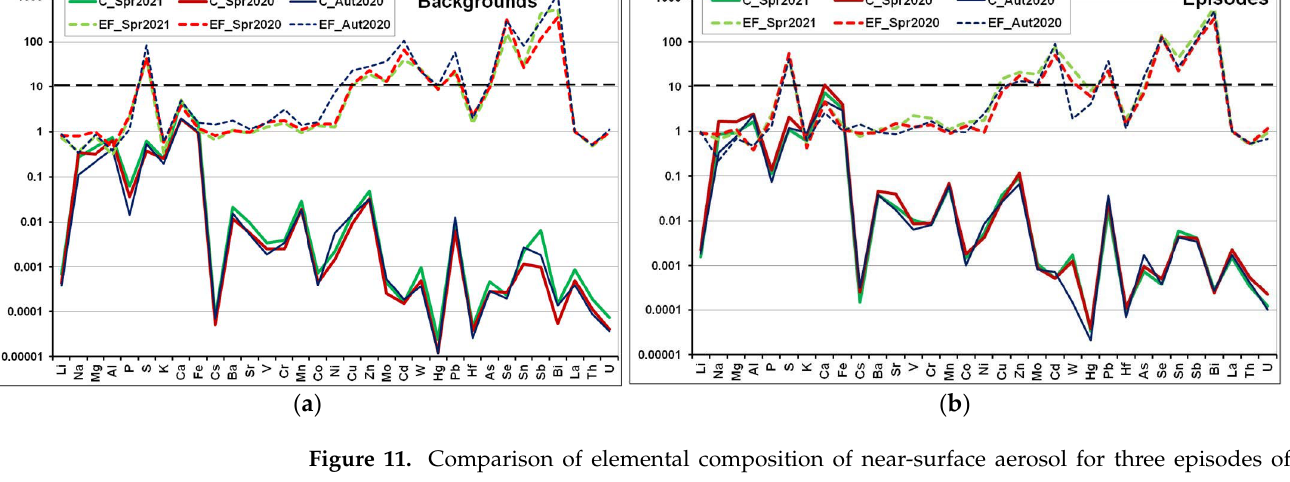
Figure 12. The relative excess of elemental mass concentrations Δ C (formula 2) compared to the background (BG) level (see the text) during three episodes, as well the relative excess of elemental concentration for Kalmykia arid aerosol [27] compared to the background elemental concentrations for autumn 2020 in Moscow.